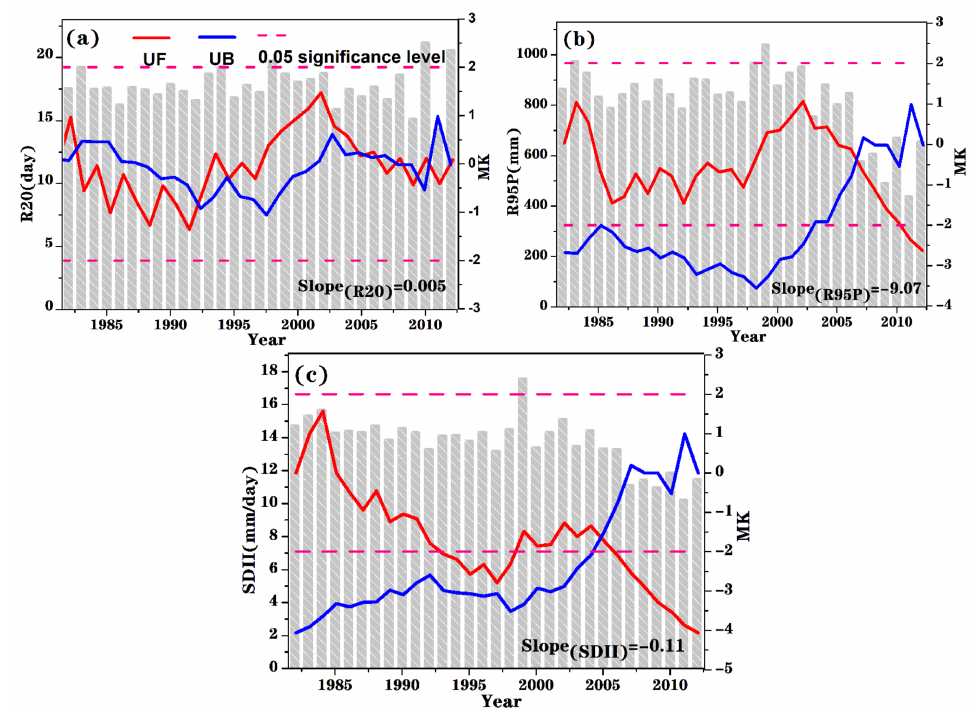
Figure 3. Interannual trends in the extreme precipitation index on the Mongolian Plateau over the last three decades.(Temporal trends of each extreme precipitation index, ( a ) R20: Number of moderate precipitation days, ( b ) R95P: Very wet days, ( c ) SDII: Annual mean rainy day precipitation